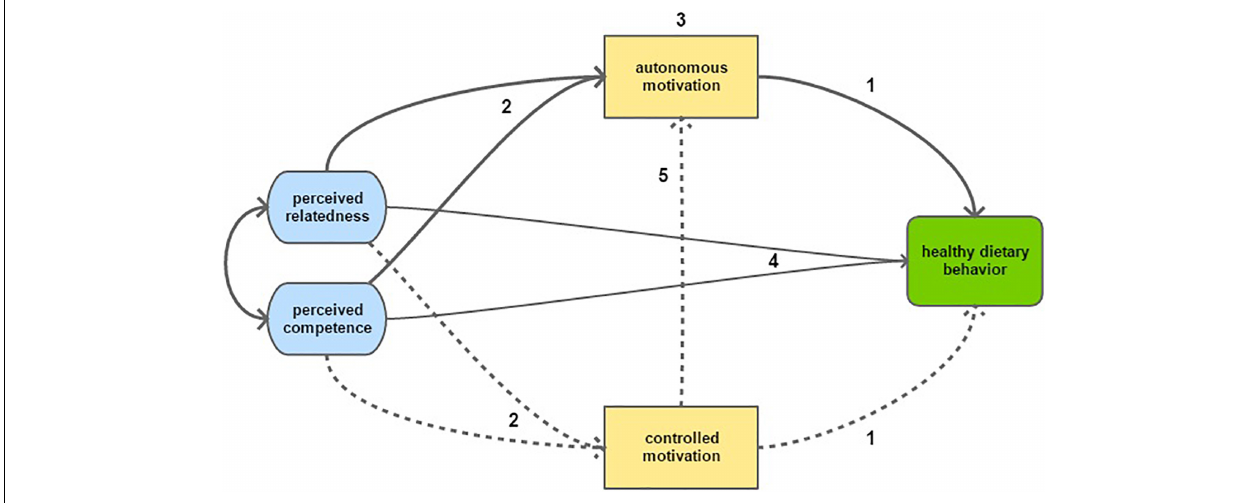
FIGURE 1 | Graphical representation of the study hypotheses, including 2 of the 3 psychological needs: perceived competence and perceived relatedness. Solid arrows represent hypothesized positive associations, while dotted arrows represent hypothesized negative associations. Numbers relate to the hypotheses presented in the